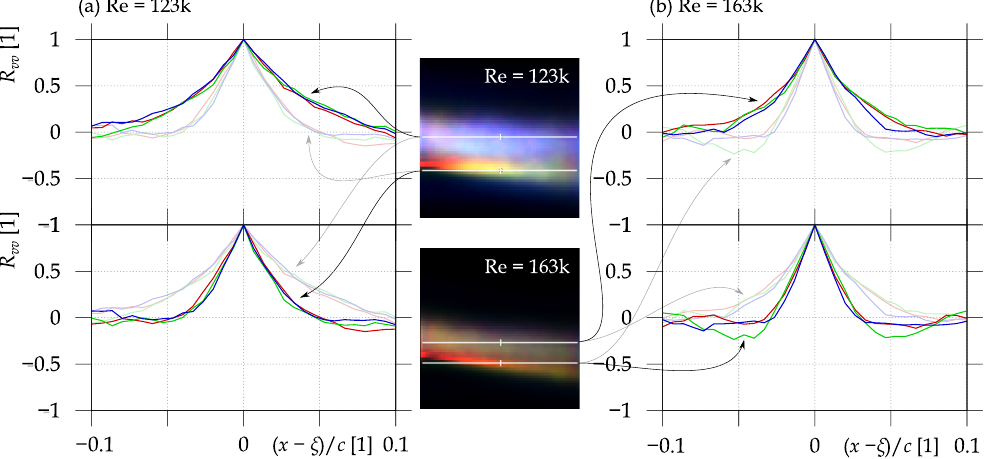
Figure A5. Autocorrelation function of fluctuating cross-stream velocity component v at two Rey- nolds numbers 1.23 × 10 5 ( a ) and 1.63 × 10 5 ( b ), where the flow is attached at α = 10 ◦ . First, the autocorrelation with the reference point in the suction part of the wake ( top ) and second with the reference point in the pressure part of the wake ( bottom ).